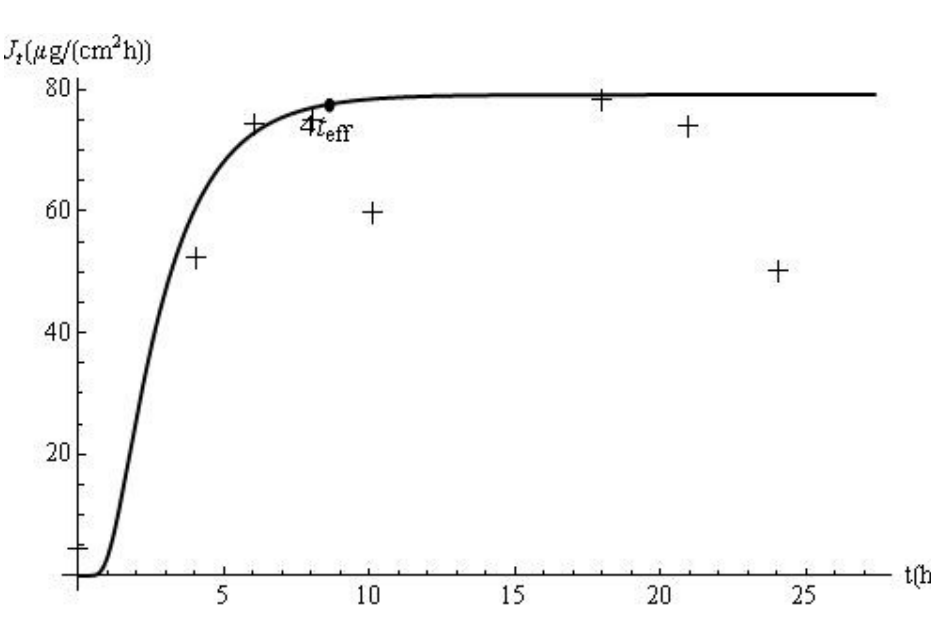
Figure 2. Metoprolol flux versus time (experimental: +; predicted: